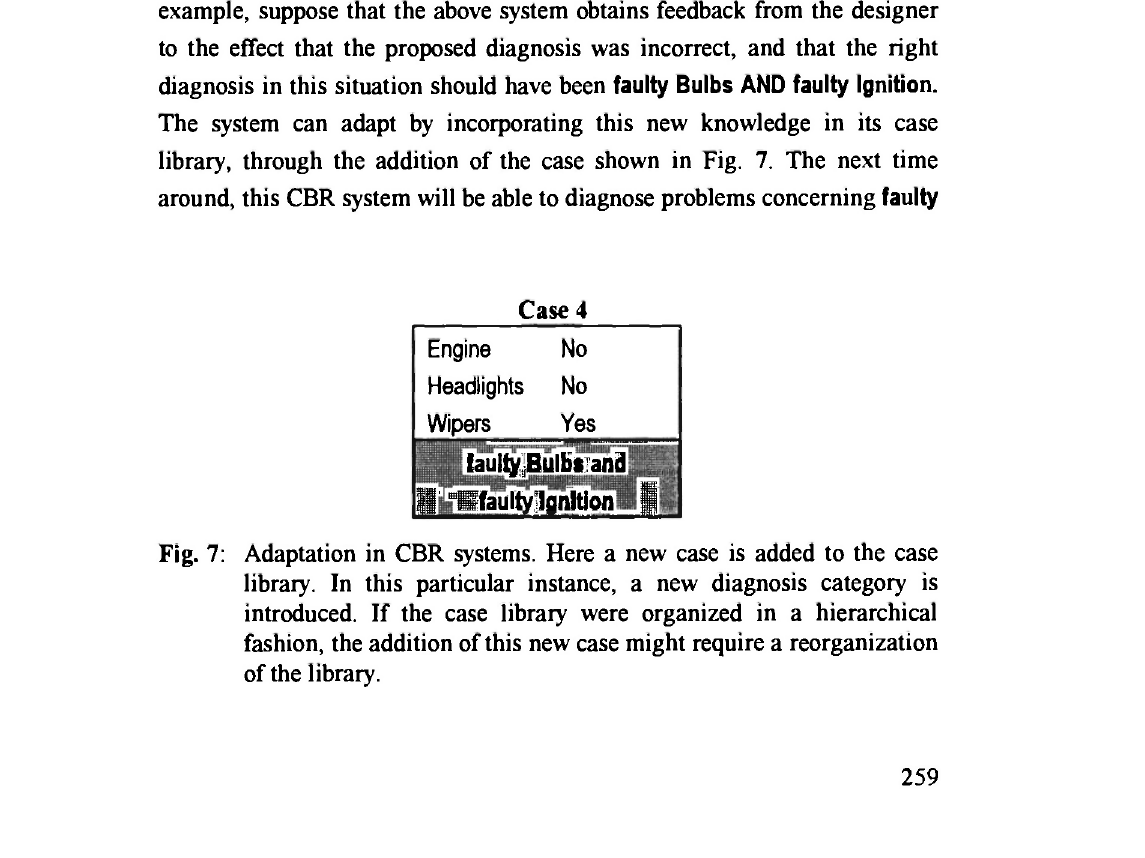
Fig. 7: Adaptation in CBR systems. Here a new case is added to the case library. In this particular instance, a new diagnosis category is introduced. If the case library were organized in a hierarchical fashion, the addition of this new case might require a reorganization of the